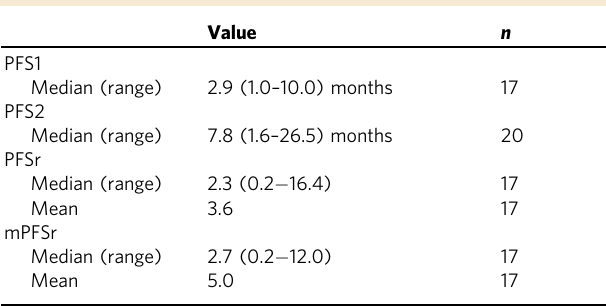
Overview including PFS1, PFS2, PFSr, mPFSr, depicting respective median and mean values. For three patients, PFS1 could not be determined since there was no progression reported. Modi fi ed PFS ratio (mPFSr), prePFS and postPFS were calculated as described by Mock et al. 34 PFS1 progression-free survival time 1 (last systemic treatment prior to application of